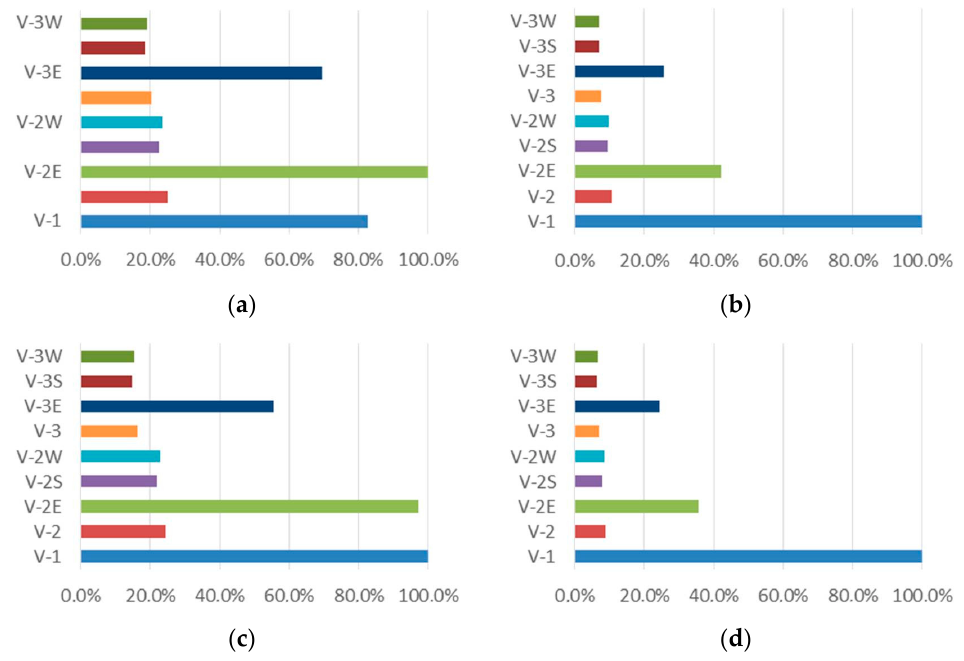
Figure 9. Influence of the functional equivalent on the interpretation of LCA results. Percentage ratios of environmental impacts of the assessed house variants per ( a ) year of operation, ( b ) year of operation and 1 m 2 of treated floor area (TFA), ( c ) year of operation and 1 m 2 of gross floor area, and ( d ) year of operation and 1 m 3 of treated volume.